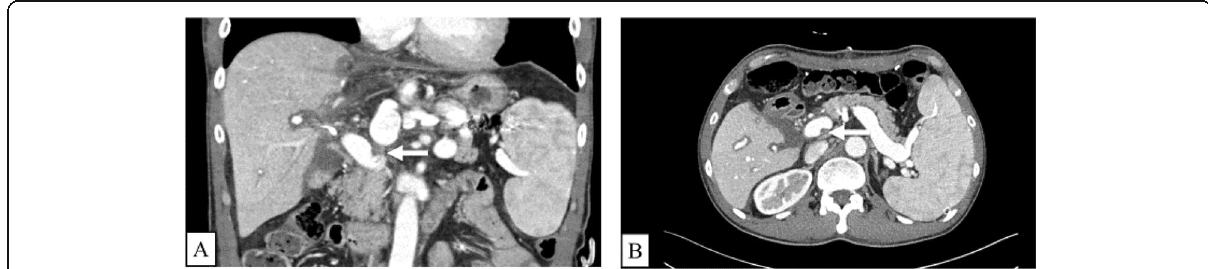
Fig. 2 The CT findings of the post-transplant PVT before and the administration of AT III. Post-transplant PVT before the administration of AT III appeared in the left side of the main portal vein at the side of left gastric vein ligation ( a and b